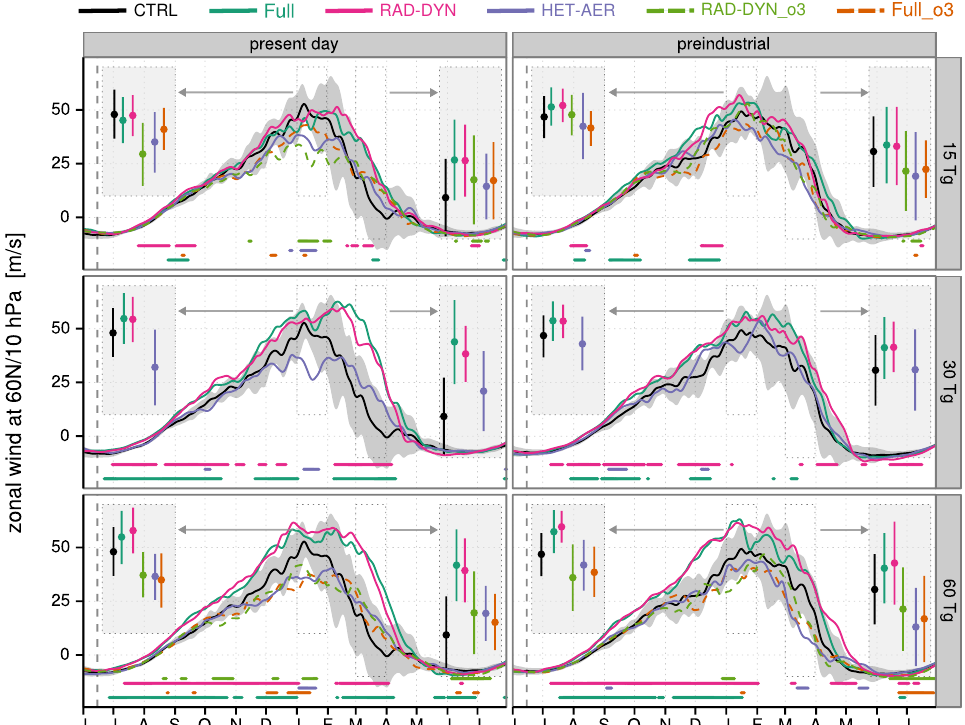
Figure 7. Daily zonal mean zonal wind at 60 ◦ N [ms − 1 ] used as index for the NH polar vortex intensity. Dots at the bottom of each panel indicate days with significant differences to the control ensemble ( p ≤ 0 . 05). All values are smoothed with an 11 day low pass filter. The start of the eruption (middle of June) is indicated by the vertical dashed line. The shading indicates the standard deviation in the control experiments. Additionally, each panel displays the monthly mean statistics for January (left) and March (right) with the dots representing the mean value and the line range corresponding to the standard deviation for each ensemble